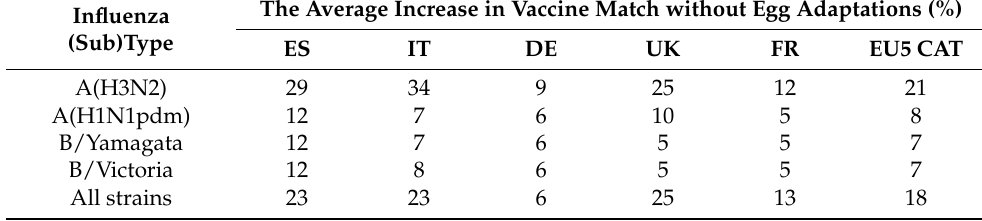
Table A4. Country-level and EU5-level survey responses on the influenza VM increase without egg